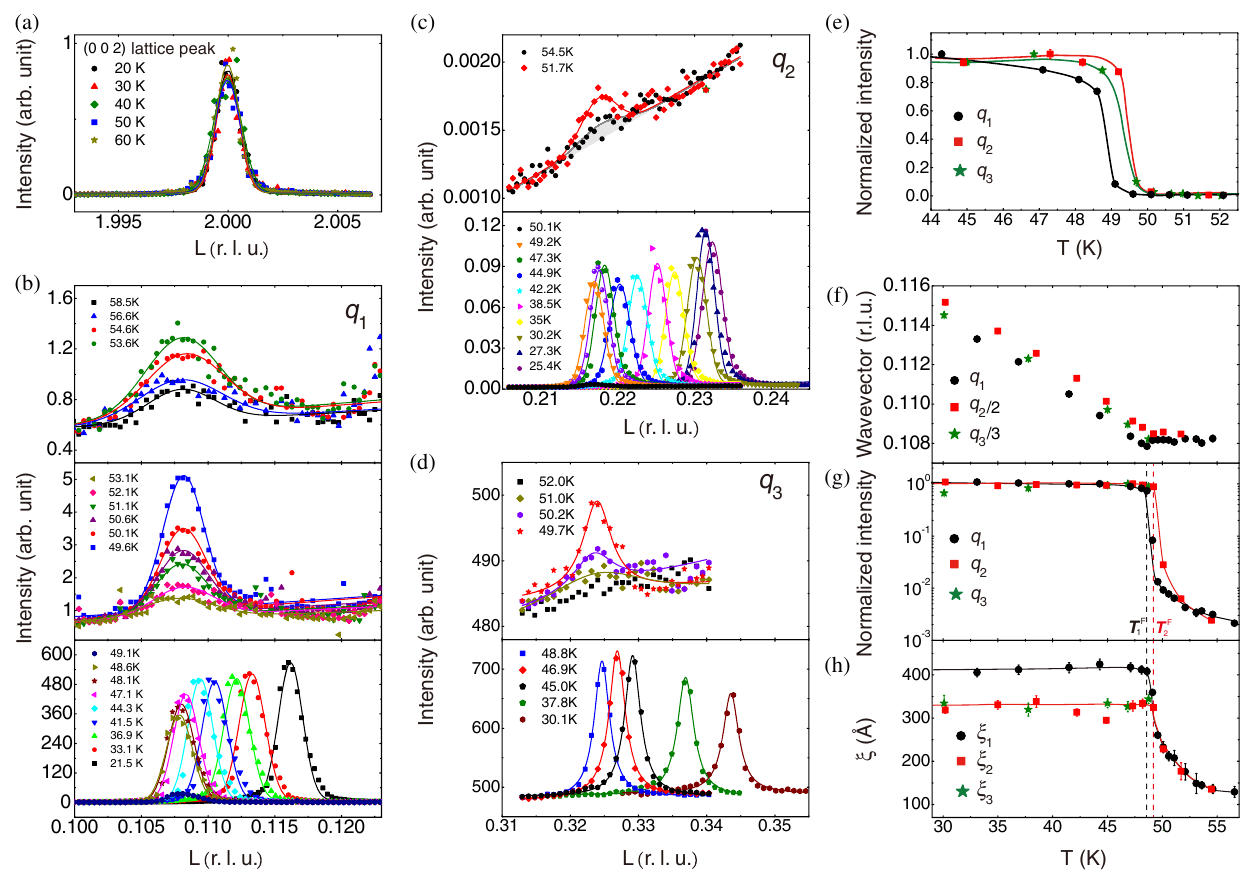
FIG. 2. Temperature dependencies of the diffractions peaks in MnP. (a) (0 0 2) lattice peak measured at 2180 eV from 20 to 60 K. (b) – (d), q 1 L 3 ( E ¼ 637 eV, π polarization), q 2 L 2 ( E ¼ 648 . 8 eV, π polarization), and q 3 L 3 ( E ¼ 636 . 6 eV, π polarization) resonance peaks at different temperatures, measured on cooling. The solid lines in each panel are Gaussian (for q 1 and q 2 resonance peaks) or Lorentz (for q 3 resonance peaks) fittings with a linear background. The shadowed area in the upper panel in (c) is to indicate the weak peak intensity at the highest measured temperature. (e) Temperature dependence of the peak area of q 1 , q 2 , and q 3 near the helical transition, revealing their differing transition temperatures. The data are obtained in the cooling processes. Solid lines are guides to the eye. (f) Temperature dependences of the q 1 , q 2 = 2 , and q 3 = 3 . Here, we use a photodiode detector for q 1 , a channeltron detector for q 2 , and a Greateyes CCD for q 3 . (g) and (h) are the temperature dependences of the peak area and 1/FWHM for q 1 (black circles) and q 2 (red squares) resonance peaks in the cooling measurements, respectively. (g) and (e) display the same set of data but use different scales. In (g), the log scale is used for the vertical axis in order to reveal the detailed high-temperature evolution. The solid lines are guides to the